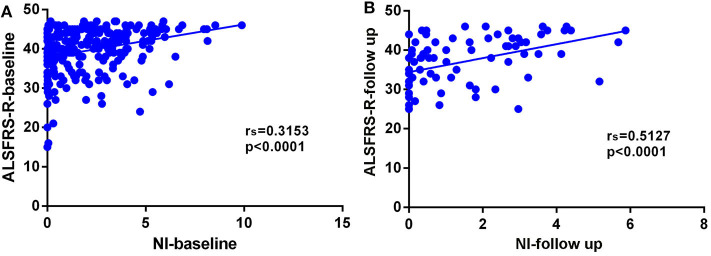
(A) Correlation between NI and ALSFRS-R scores at baseline (rs = 0.3153, p < 0.0001). (B) Correlation between NI and ALSFRS-R scores at different time points of follow-up (rs = 0.5127, p < 0.0001). NI, neurophysiological index; ALSFRS-R, amyotrophic lateral sclerosis functional rating scale-revised; rs, Spearman coefficient.